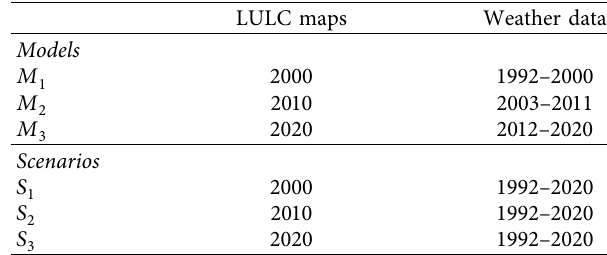
Table 6: Models and scenarios created in response to LULC and weather data.